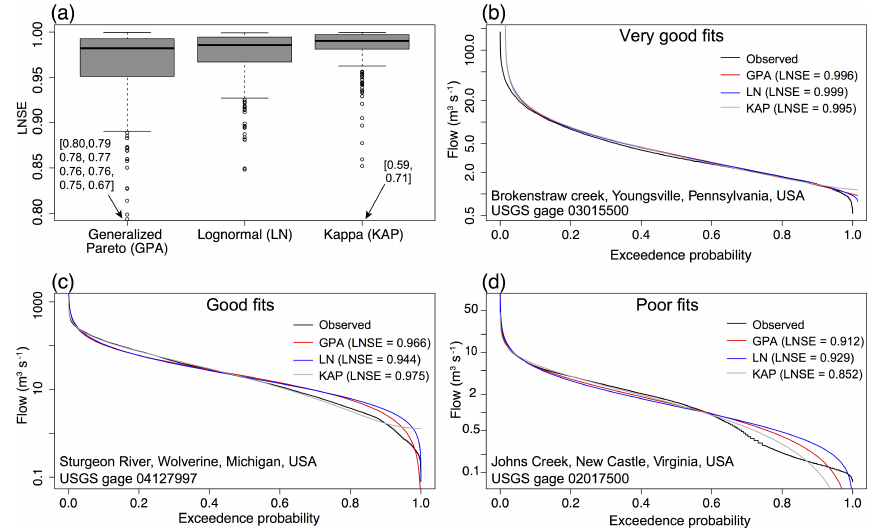
Figure 3. (a) Boxplots showing the range of streamgage Nash–Sutcliffe efficiencies for natural logarithms of daily streamflows (LNSE) based on hypothesized generalized Pareto (GPA), lognormal (LN), and kappa (KAP) distributions with points omitted from the plots listed in brackets, and example streamgage sites with (b) very good fits (LNSE above 0.99), (c) good fits (LNSE between 0.93 and 0.99), and (d) poor fits (LNSEs below